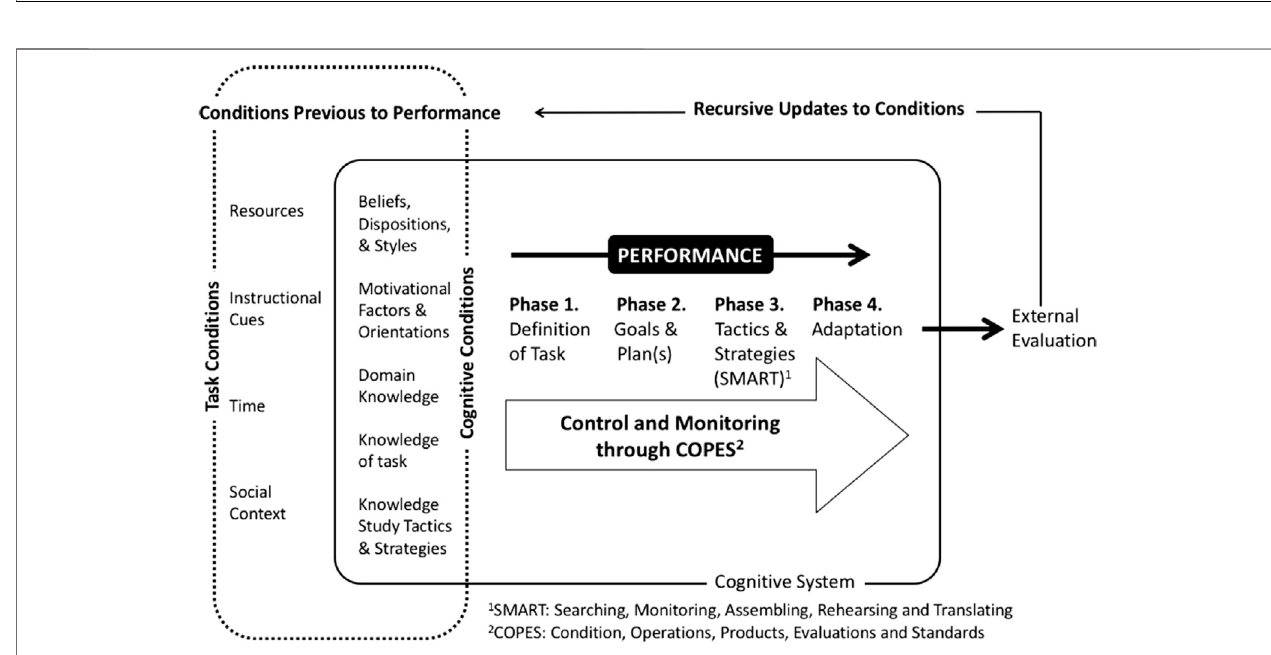
FIGURE 5 | Modi fi ed version of Winne ’ s SRL model (extracted from Panadero et al.,